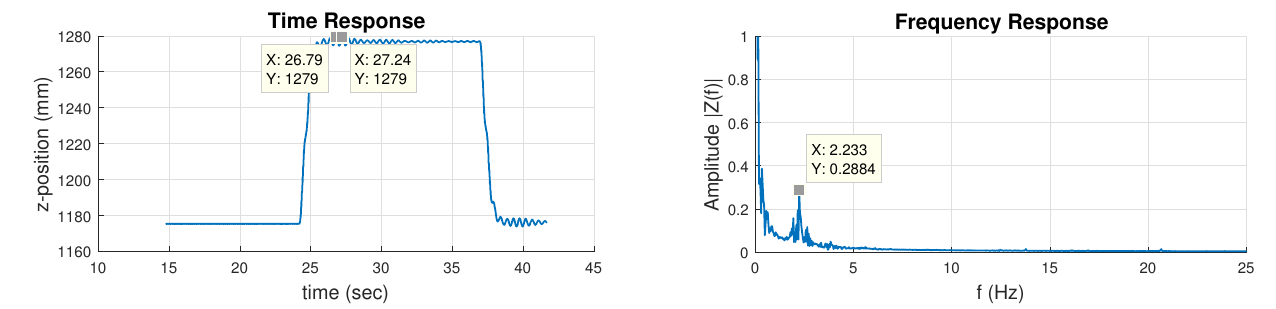
Figure 12. Panel vibration, measured by the motion capture system, shows the dominant vibrational mode around 2.23 Hz. Robot motion bandwidth is chosen below this mode to avoid panel